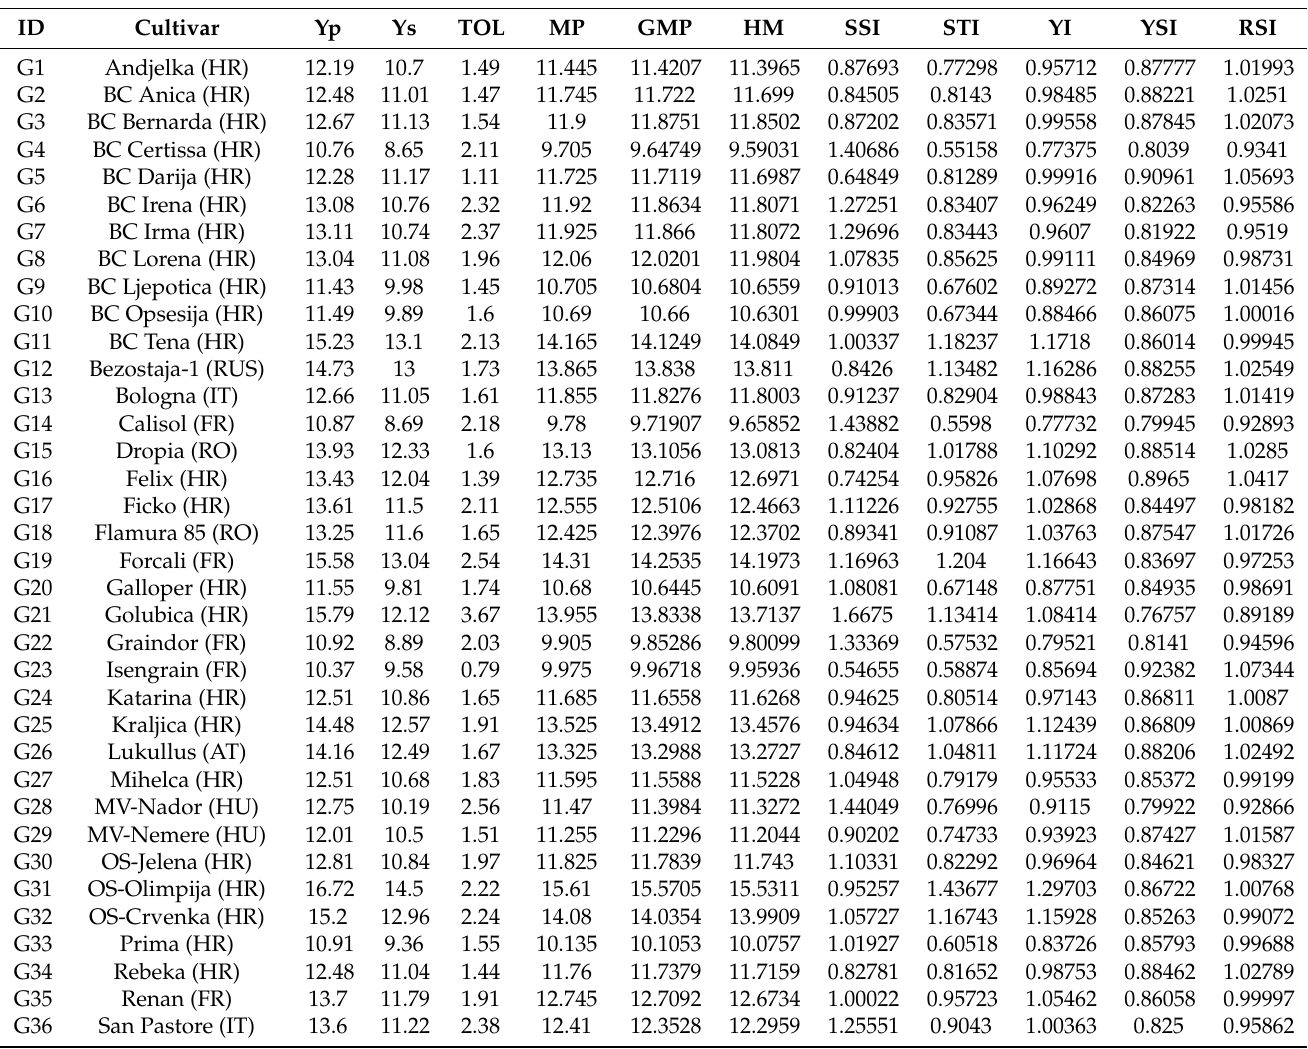
Table 4. BLUP values for the grain protein content (%) and stress screening index